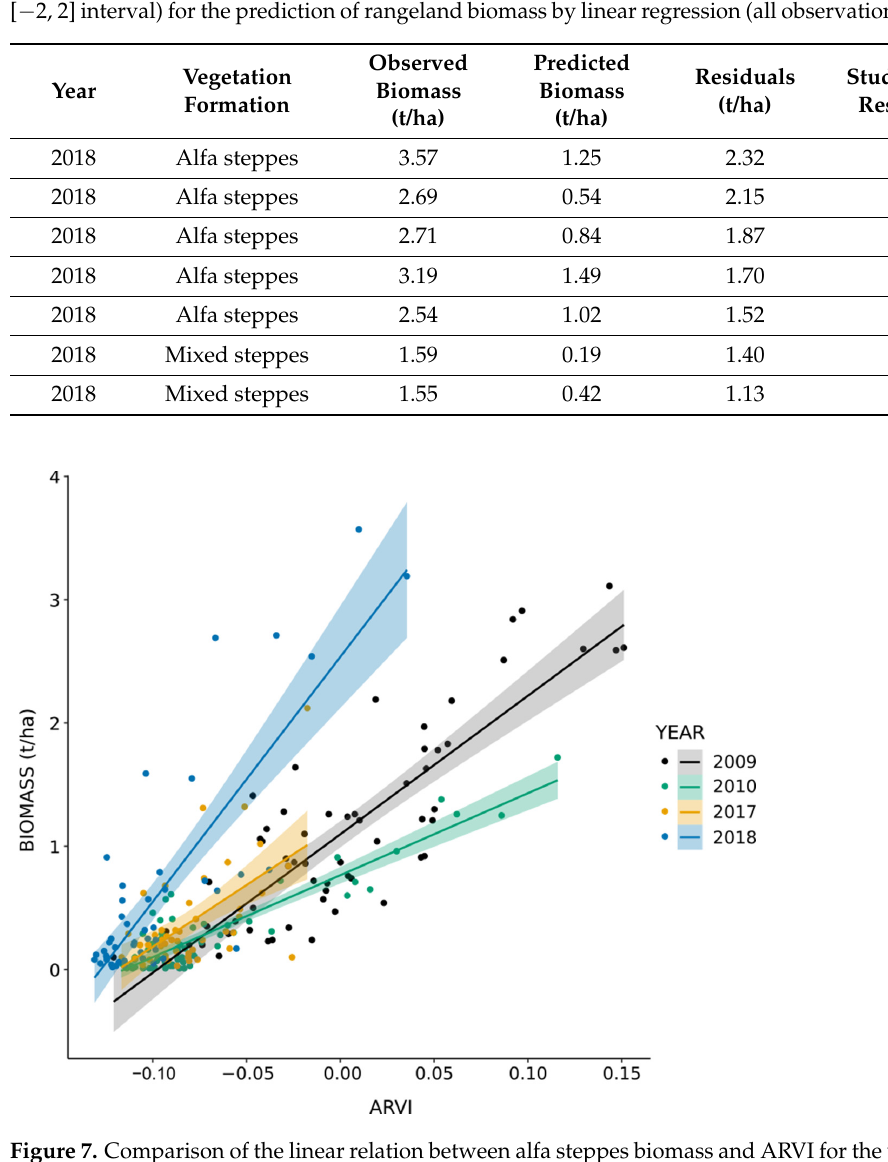
Figure 7. Comparison of the linear relation between alfa steppes biomass and ARVI for the years 2009, 2010, 2017, and 2018. Solid and dashed lines = linear regression, grey/color area = 95% confidence interval on the regression line. (See Figure S6 for a black and white version.). Table 8. Parameters and significance of the linear models linking alfa steppes biomass and ARVI for the years 2009, 2010, 2017, and 2018. (***: p ≤ 0.001, **: p ≤ 0.01).